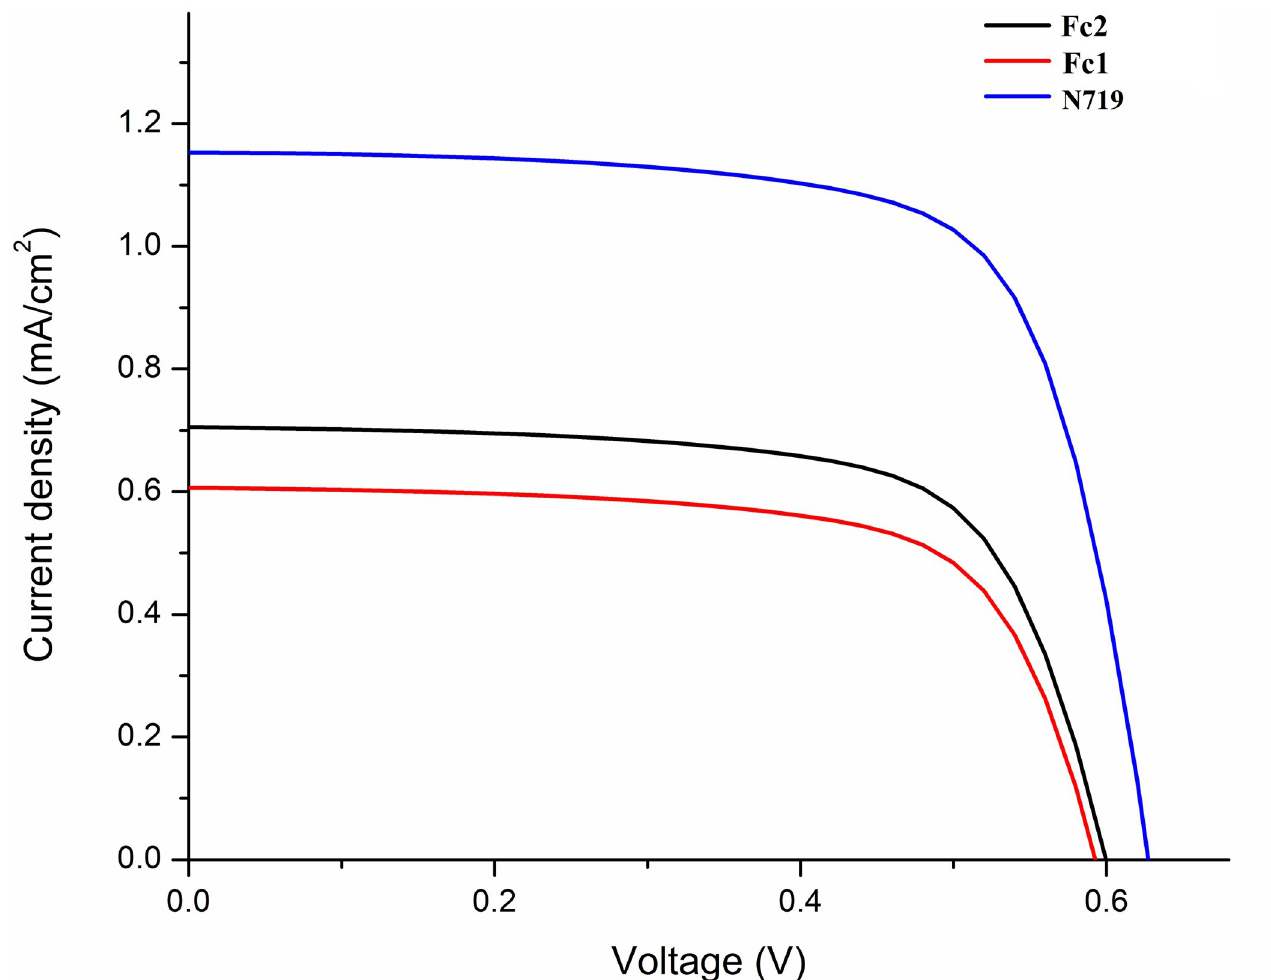
Fig 12. J - V curves for DSSCs based on Fc1 and Fc2 sensitized photoelectrodes and N719 sensitize photoelectrodes under irradiance. https://doi.org/10.1371/journal.pone.0241113.g013 (52.70%). Initially, the deposition of dye Fc1 showed deep red colour, whereas dye Fc2 appeared a slightly pale red colour on the TiO surface. A good absorption of the dye sensitizer 2 enables more photons to be absorbed, thus enhancing the photocurrent by bringing more elec- tron injection to the nanocrystalline TiO layer. Due to this reason, compound Fc2 is capable 2 to yield better overall performance if the dye absorption on TiO surface is improved. 2 Validation of the photovoltaic performance was done by comparing all the parameters obtained of the N719 with the previously reported studies [71, 72]. To analytically solve the single-diode equivalent-circuit model under various illumination, the Shockley Eq (1) can be